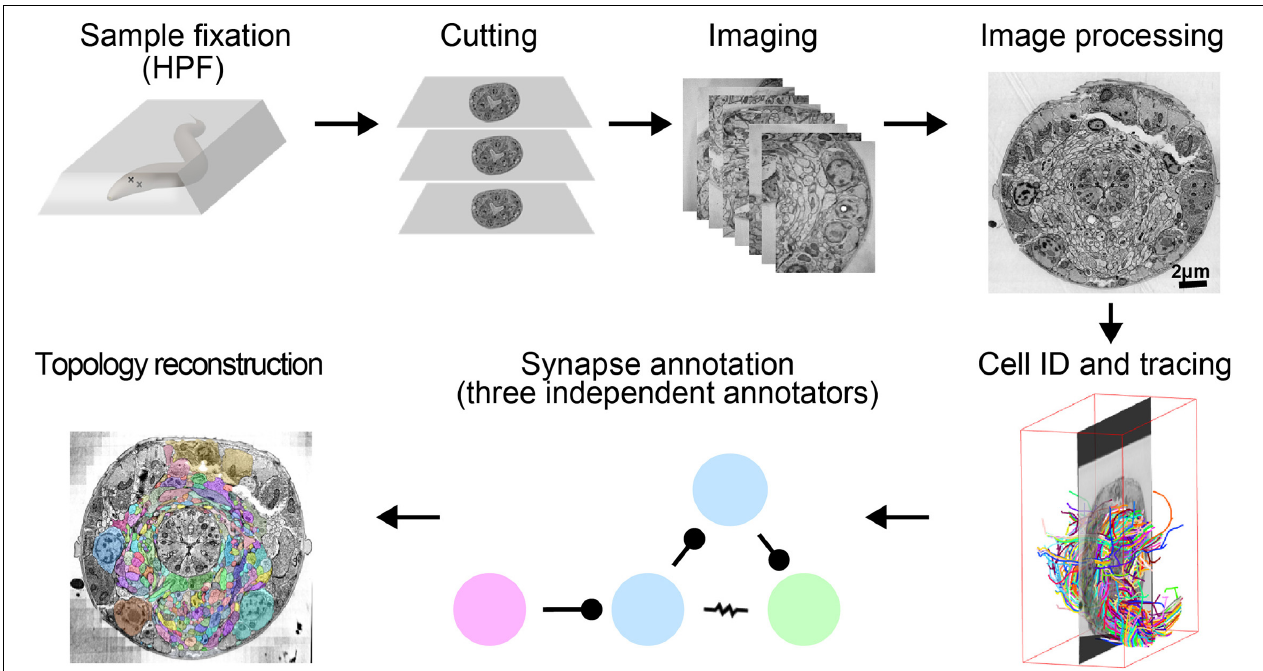
FIGURE 1 | A pipeline for C. elegans connectome reconstruction using vEM. Samples are fixed using high-pressure freezing and freeze substitution, embedded in plastic then cut into ultrathin serial sections before imaging on an electron microscope. Images are stitched together into a 3D volume, and neurons are identified and traced throughout the dataset by skeleton tracing using CATMAID. Synapses are annotated by three independent annotators to obtain the connectome. Volumetric reconstruction, which yields topographical information of cells and neurons, is facilitated by computational filling followed by manual proofreading using